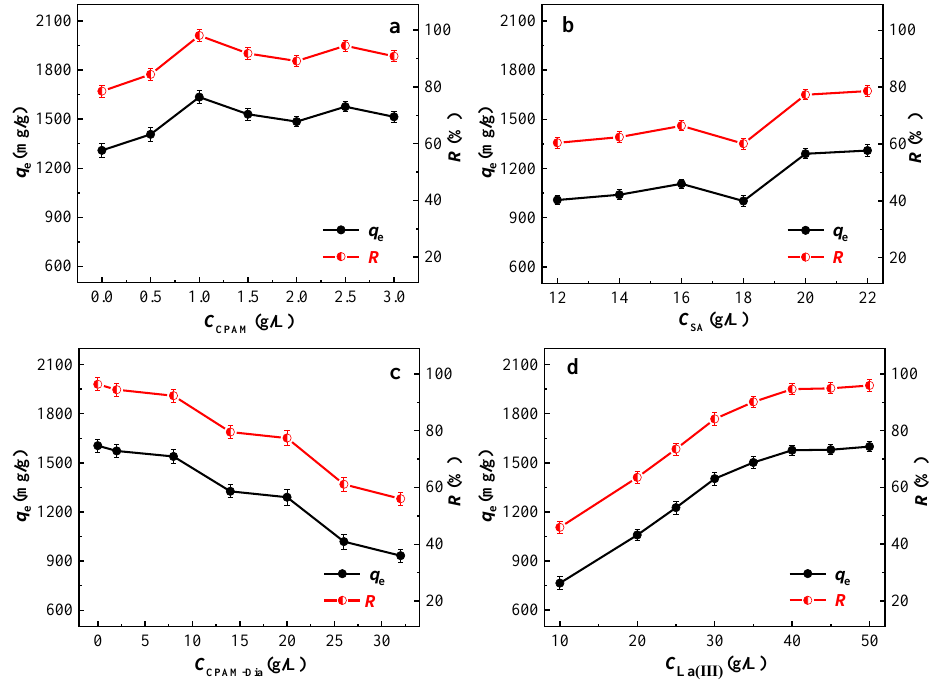
Figure 1. Effect of the concentration of CPAM ( a ), SA ( b ), CPAM-Dia ( c ) and La(III) ( d ) on the adsorption property of the gel spheres (2000 mg/L Dye solution 25 mL).